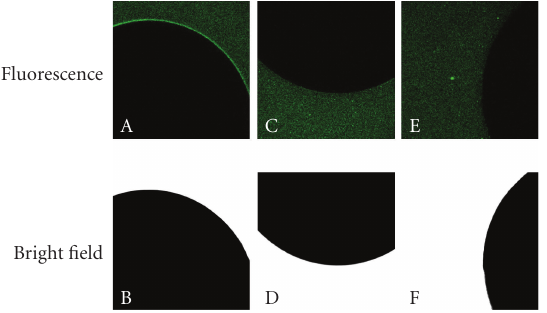
Figure 5: Fluorescence images (top row) and bright-field images (bottom row) of oocytes incubated with qdot-containing com- pounds for 10 minutes. The bright-field images illustrate the plane of focus of the opaque oocyte. Panels A and B show results from a human ρ 1 GABA C -expressing oocyte incubated with 34nM muscimol-conjugated AMP-coated qdots. Panels C and D show a human ρ 1 GABA C -expressing oocyte incubated with a 34nM solution of unconjugated AMP-coated qdots. Panels E and F show a nonexpressing oocyte incubated with 34nM muscimol-conjugated AMP-coated qdots. Adapted from Gussin et al.